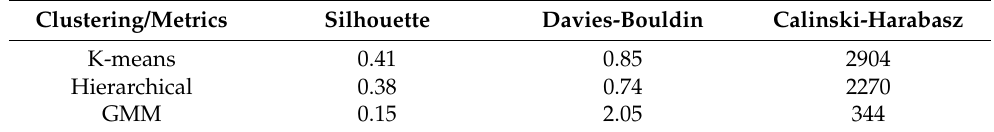
Table 1. Internal validation